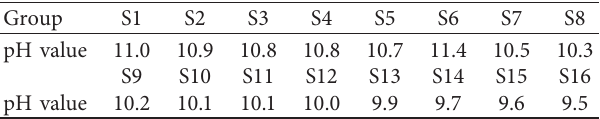
Table 6: The pH value of the waste sediment-based grouting material.